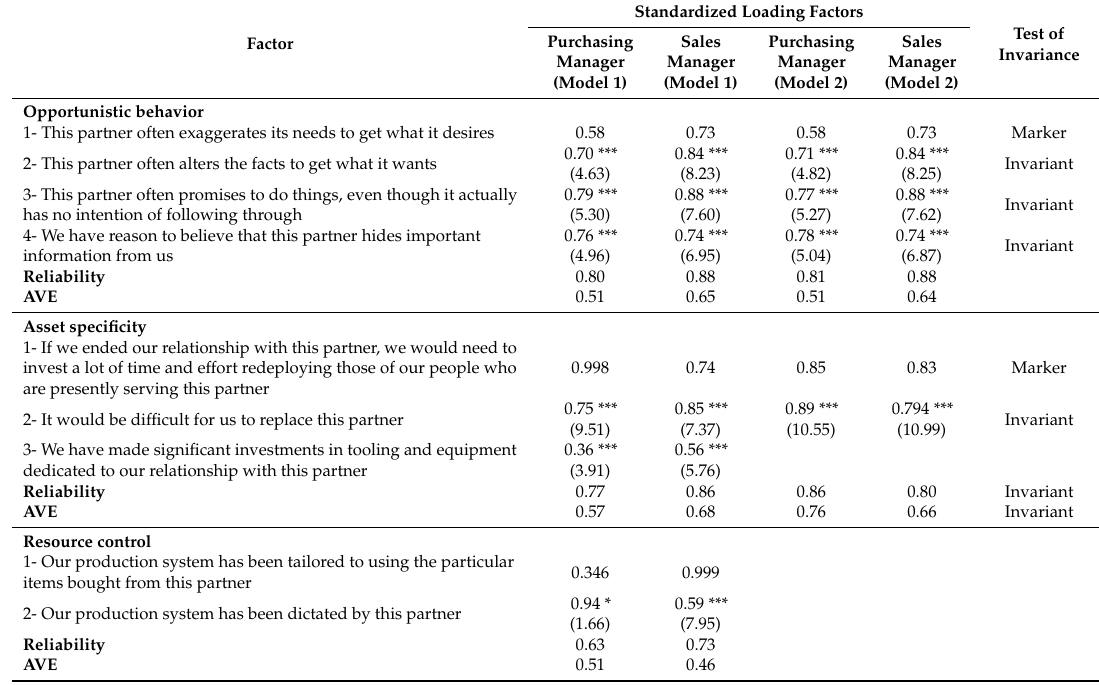
Table 2. Metric invariance assessment across